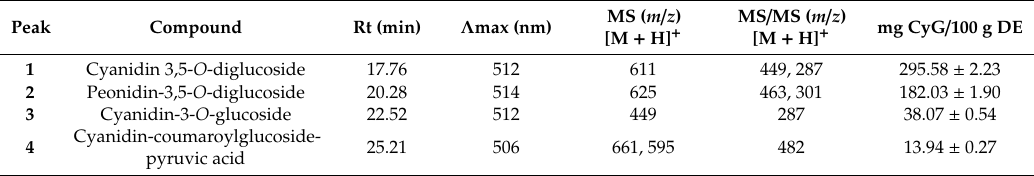
Table 1. Anthocyanin profile of EAC by RP-HPLC-DAD-ESI-MS/MS analysis. Results represent the mean ± SD ( n = 3) of three independent experiments, and are expressed as mg cyanidin-3- O -glucoside equivalents (CyG/100 g of dry extract (DE)).